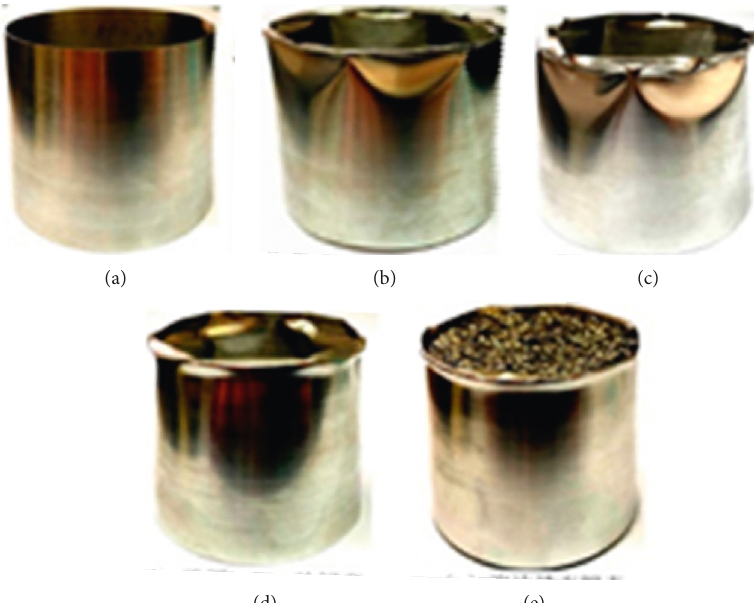
Figure 10: Deformation of experiment. (a) Before test, (b) thin wall with a thickness of 0.2, (c) thin wall with a thickness of 0.3mm(d), thin wall with a thickness of 0.4mm, and (e) FTS.